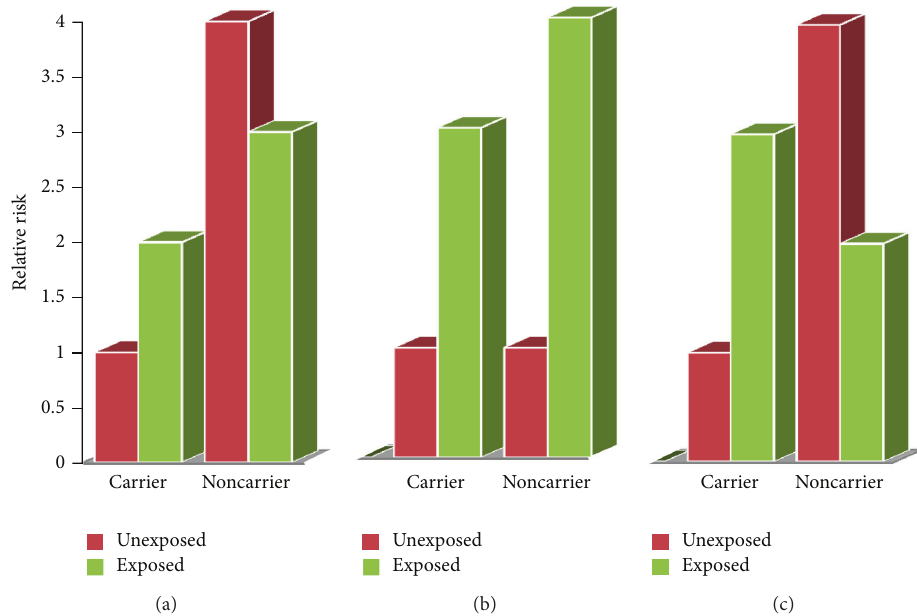
F 1: ree different types of interaction effects for a dichotomous outcome, such as diabetes. (a) shows a “removable interaction.” In this scenario, the genotype exerts an effect in people who are exposed as well as in those who are not exposed to the environmental risk factor, but larger genetic effect in one environmental exposure group than in the other. (b) shows a “nonremovable, pure interaction,” which is characterized by the presence of a genetic effect only in one of the two environmental exposure groups. (c) shows a “cross-over” interaction, where a genotype conveys risk of disease in people who are exposed to the environmental risk factor, but is protective of disease in persons who are unexposed to the same environmental